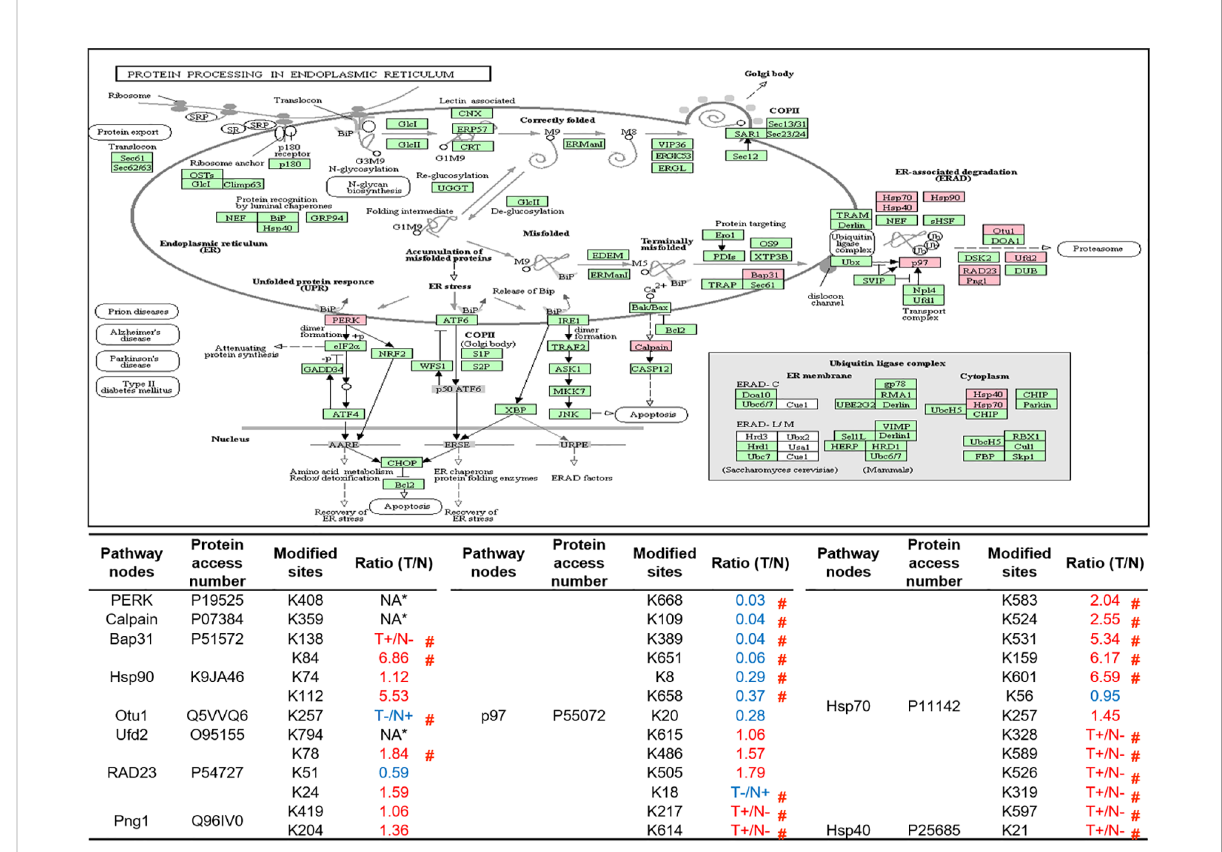
FIGURE 8 Ubiquitination-mediated endoplasmic reticulum protein processing pathway. Pink = the identi fi ed ubiquitinated subunits. Green=non-ubiquitinated subunits. K* = ubiquitinated lysine residue. Red indicates the degree of ubiquitination of this site is upregulated, and blue indicates downregulated. Ratio(T/N) = Ratio of tumor to control. T+/N- = ubiquitination only in tumor. T-/N+ = ubiquitination only in control. NA* means no quantitative information in both tumor and control. # means statistically signi fi cantly altered ubiquitination level in tumor compared to